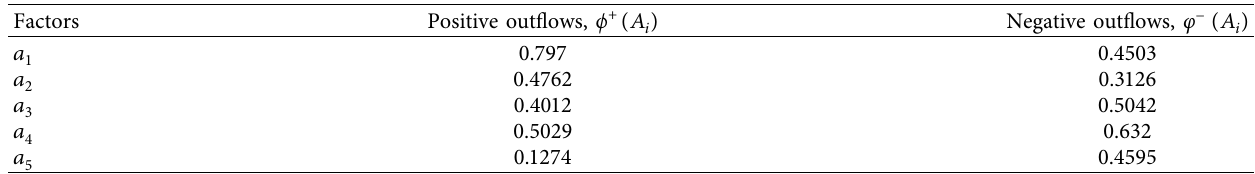
Table 17: Defuzzified fuzzy PROMETHEE I